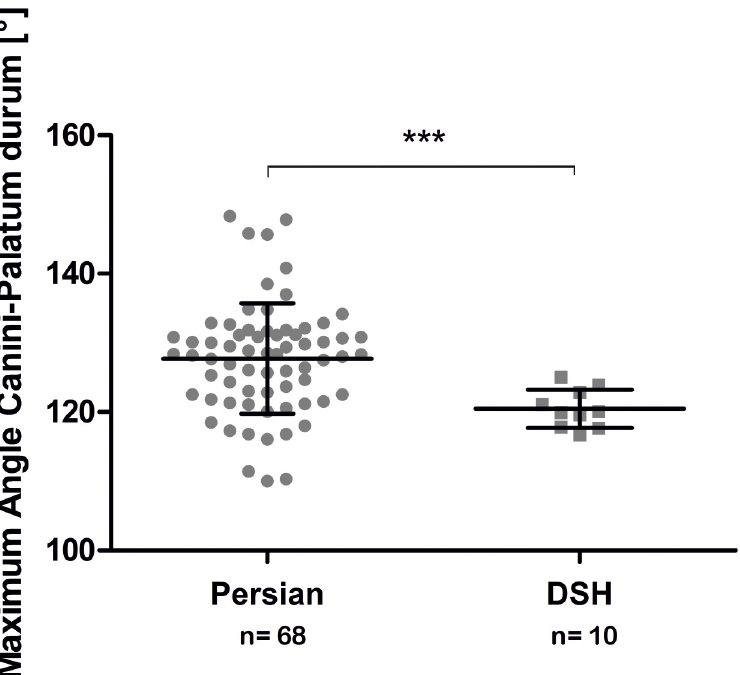
Fig 16. Comparison of the maximum angle between the canine tooth and the hard palate between Persian and Domestic shorthair cats. Graphic representation of the maximum angle between the canine tooth and the hard palate, comparing between Persian and DSH cats. The values of the individual cats, the mean values, the standard deviations and the significance level are indicated. ��� = p < 0.0001.